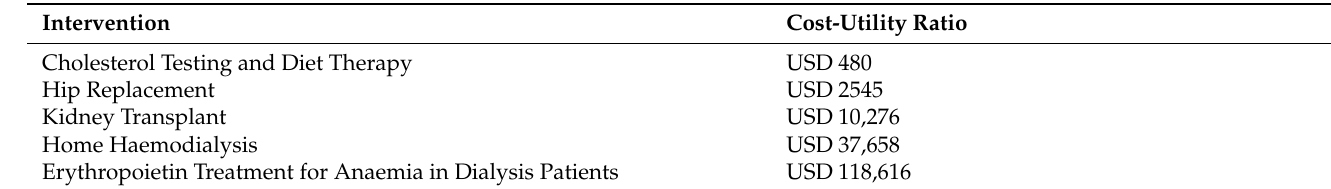
Table 3. Cost-Utility Analysis of Various Non-Dementia